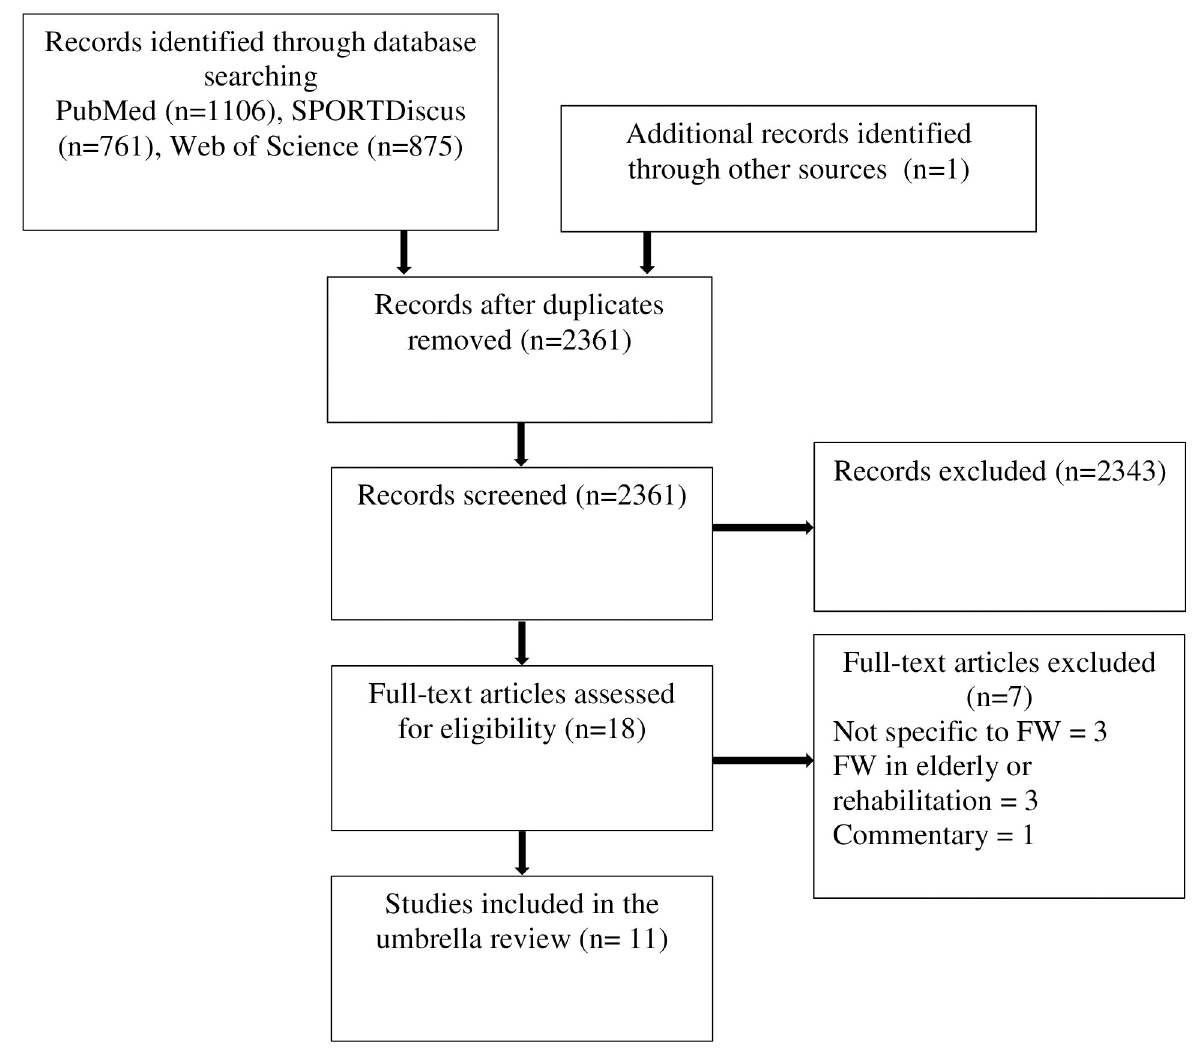
Fig 1. Flow diagram of the study retrieval